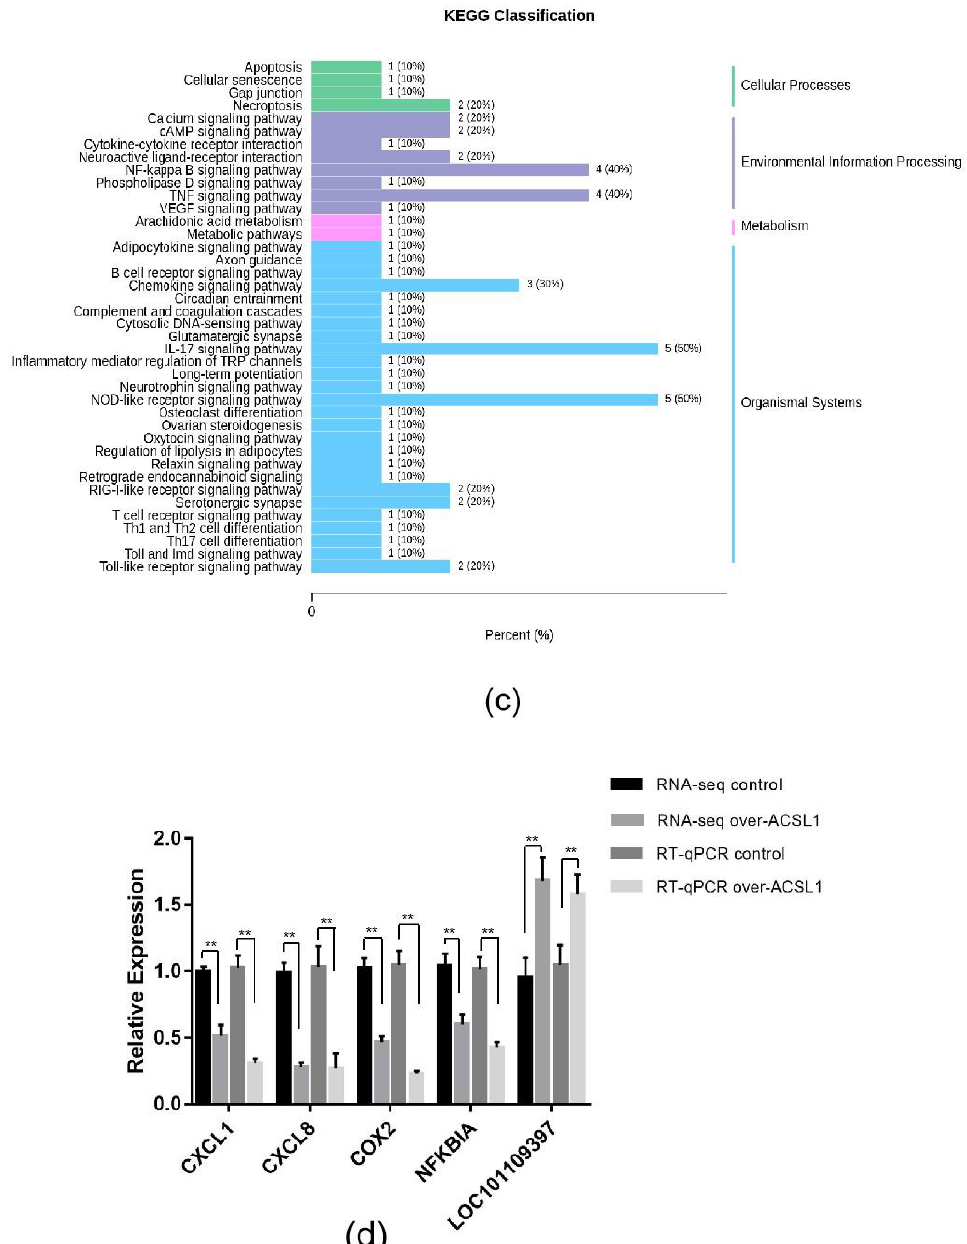
Figure 2. Transcriptome sequencing: ( a ) heat map; ( b ) volcano plots; ( c ) KEGG analysis; ( d ) RNA-seq data and qRT-PCR of sheep adipocytes (* p < 0.05). NC: Adipocytes transfected with pcDNA3.1( + ) vector as control. Over-ACSL1: Adipocytes transfected with pcDNA3.1( + ) vector with ACSL1 CDS.